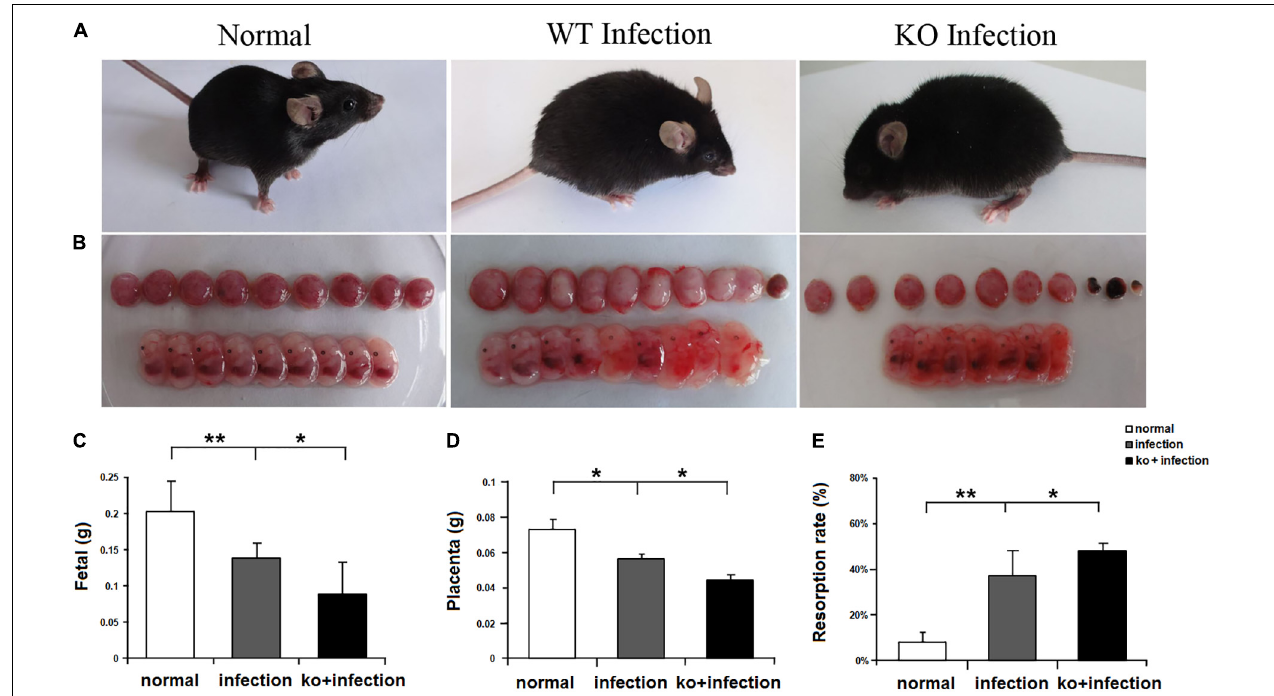
FIGURE 1 | The impact of LILRB4 on abnormal pregnancy outcomes caused by Toxoplasma gondii infection. (A) The pregnant mice and (B) their fetuses from normal wild type (WT) pregnant, T. gondii infected WT pregnant mice, and T. gondii infected LILRB4 − / − pregnant mice. (C) The weight of fetuses, (D) the weight of placentas, and (E) the resorption rate from the three groups. Data are shown as means ± SD for 10 pregnant mice and differences were identified using unpaired t -tests ( ∗ p < 0.05, ∗∗ p < 0.01).